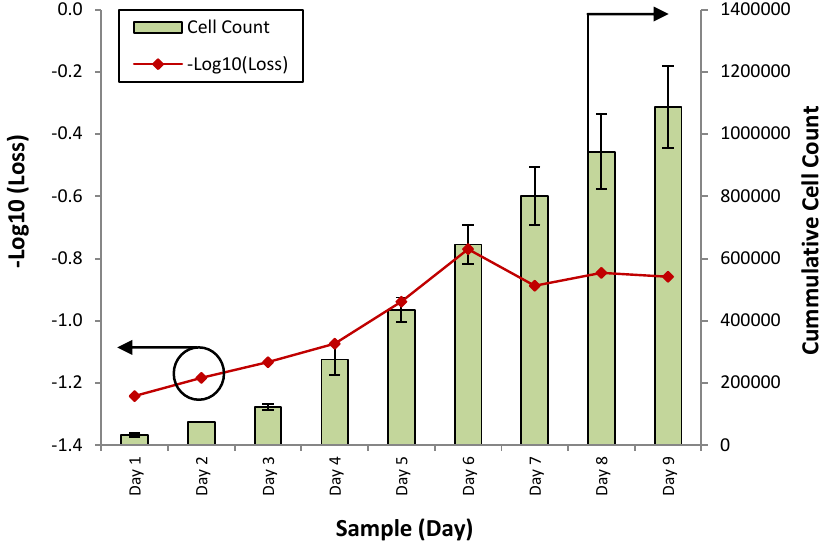
Figure 5. −Log (Power Loss) (dB) and cumulative cell count against different 10 conditioned media samples for the SCD.SC3 cell line. The power loss is represented by the line graph, with the corresponding X-axis on the left, while the cell count is represented by the bar chart, with the corresponding X-axis on the right side of the